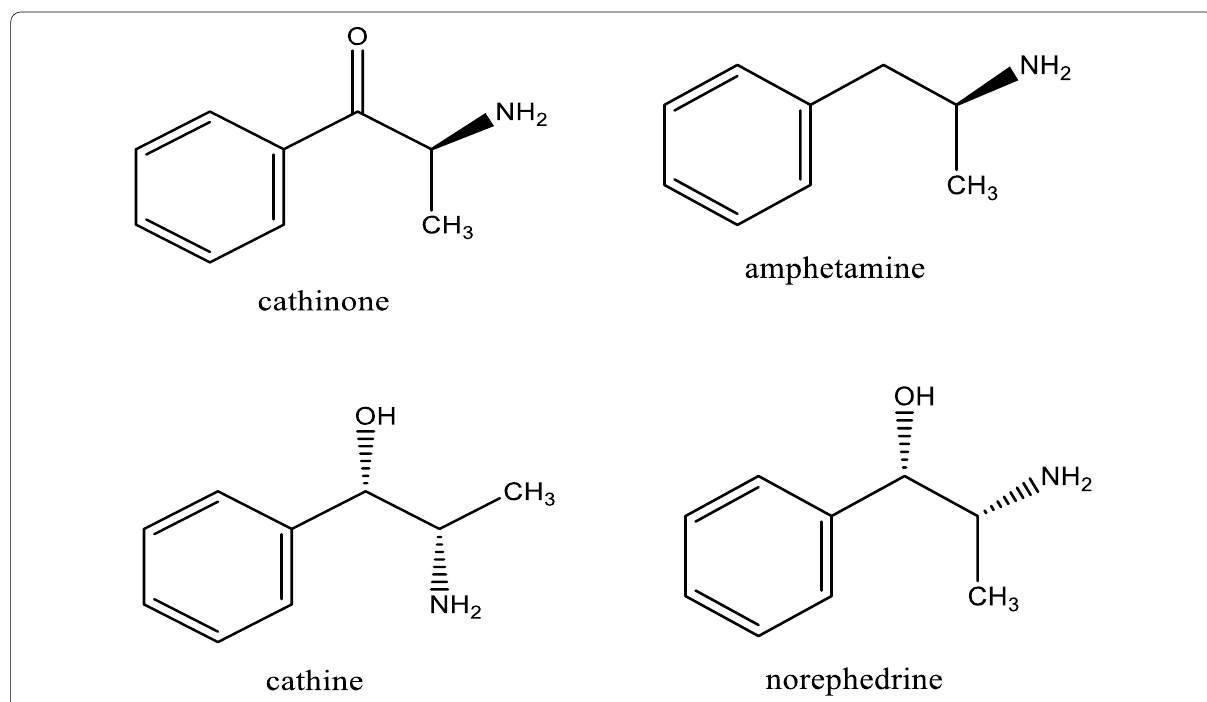
Fig. 2 Major chemical structures of psychostimulants in Khat plant—Adapted from Nigatu and Libsu